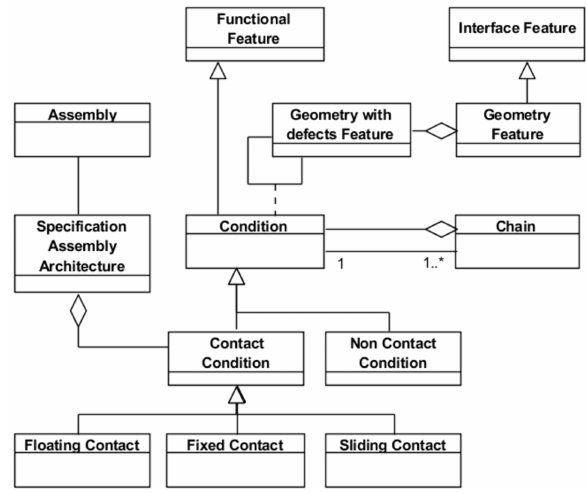
Figure 5. Assembly Model for Specification (updated from